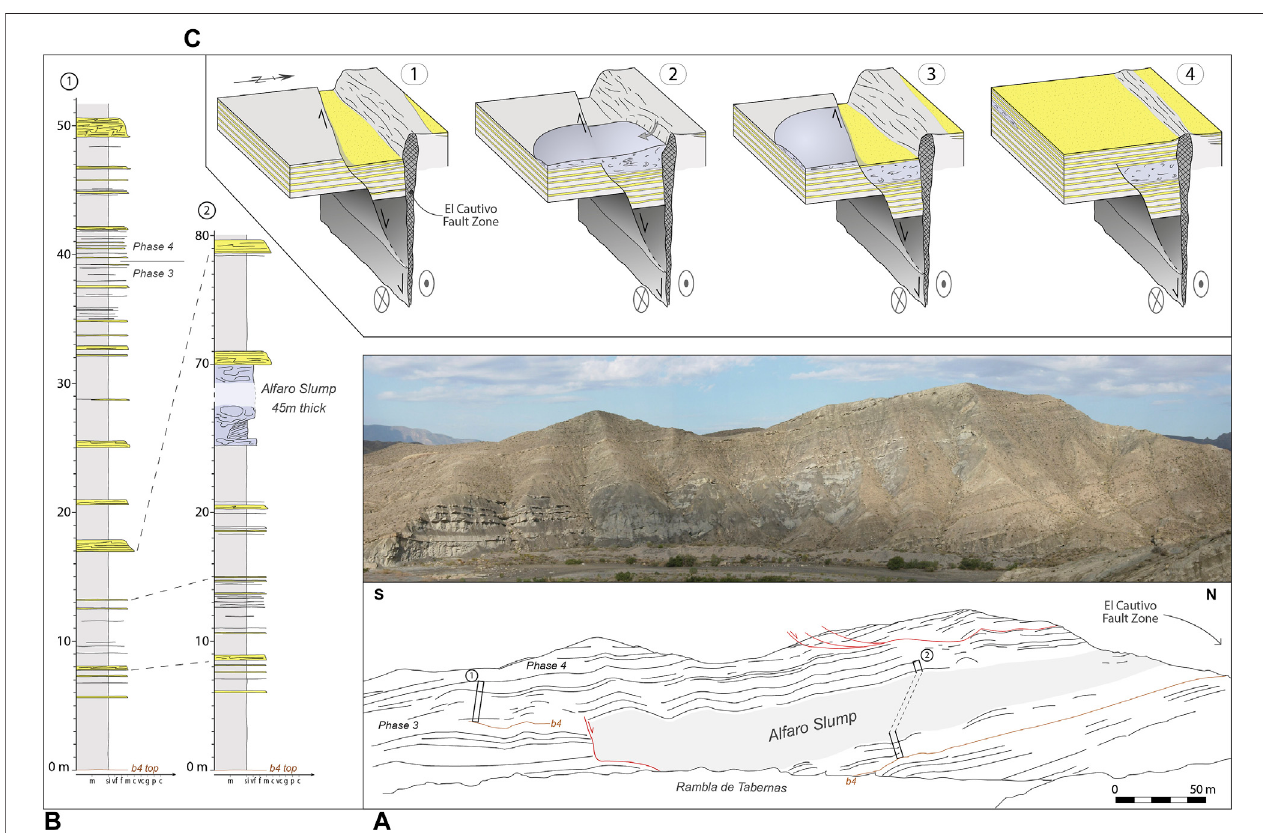
FIGURE 9 | The Alfaro Slump (see Figure 4 for location). (A) Photograph and line drawing of the Alfaro Slump (highlighted in grey) in east-facing cliffs along the Rambla de Tabernas. Marker bed 4 (see Figure 5 ) has been highlighted in brown on the line drawing; faults are represented in red (B) Bed correlation of two logged sections from either side of the southern bounding fault to the slump (see location of logs in a) showing thickening of the succession on the northern side of the fault implyingitwassyn-sedimentary.Notemudcapsarenotrepresentedontheselogs (C) Cartoonsshowingareconstructionofthefaultdisplacementonthesouthern marginoftheslumpandinferredcollapseoftheElCautivoFaultZonetocreatetheslump.1-DisplacementonasplayfaultopenedaccommodationbetweenitandtheEl Cautivofaultwithsedimentpreferentiallytrappedinagrabenbetweenthetwofaults.2-CollapseofpartofthemuddyElCautivoFaultZonescarexposedatthesea fl oor. 3-Continued dextral displacement on the splay fault offsetting the slump, with sediment still trapped within the graben. 4-End of the activity on the splay fault, with sediment deposited across the slump and its southern faulted margin. Relative shear movement on both sides of the fault is indicated by circles: circle with dot (cid:1) out of page; circle with x (cid:1) into the